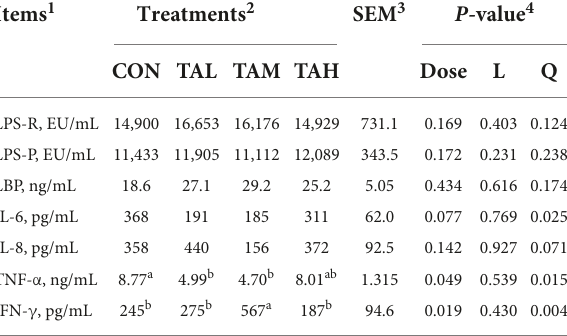
TABLE 5 Effects of tannic acid at different supplemental levels on lipopolysaccharide endotoxin in the rumen liquid and plasma, and relevant inflammatory indicators in the serum of Holstein bulls.